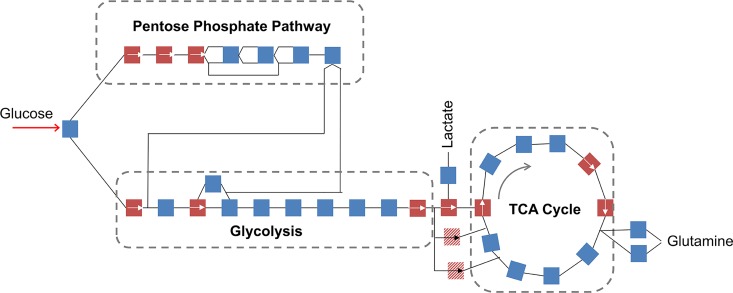
Mammalian central energy metabolism.Glucose metabolism, including the pentose phosphate pathway, glycolysis, and the TCA cycle, was modeled as a network using a stoichiometric matrix. Each colored square represents a biochemical reaction, and each line represents a metabolite. Reversible reactions shown in blue, and irreversible reactions shown in red. Arrows indicate the direction of irreversible reactions. Anaplerotic reactions that replenish TCA reactants are represented by hashed squares. The curved arrow indicates the direction of normal flux in the TCA cycle. Selected metabolites (i.e.glucose, lactate, and glutamine) shown explicitly.